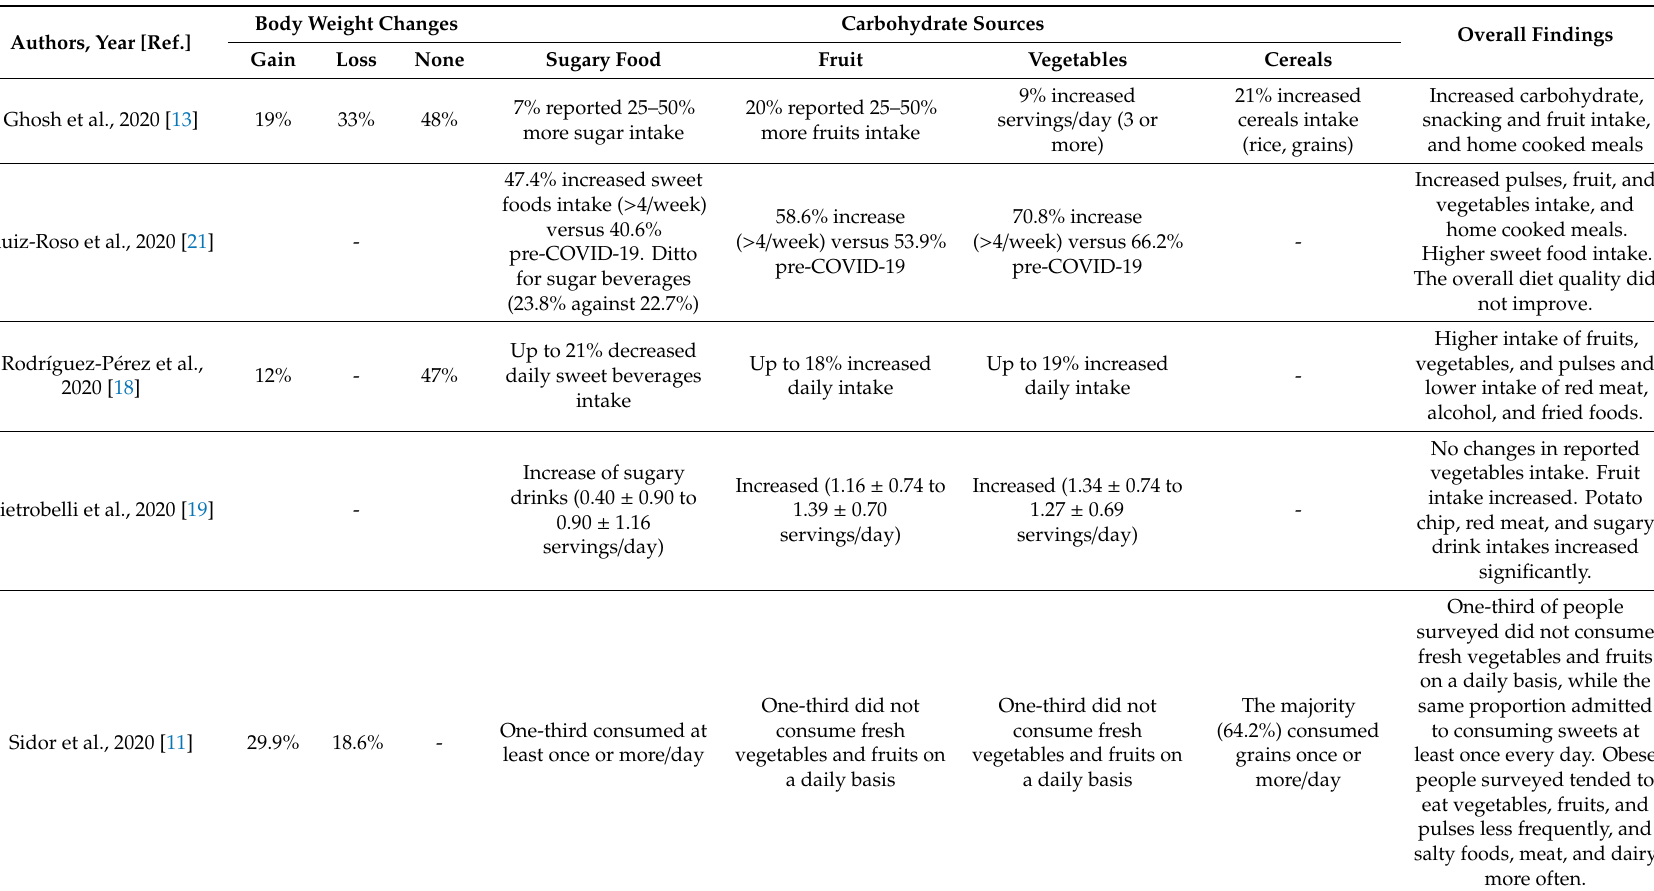
Table 3. Dietary characteristics of the study findings by principal carbohydrate sources (sugary foods, fruit, vegetables, and cereals), body weight changes (gain, loss, none) and overall